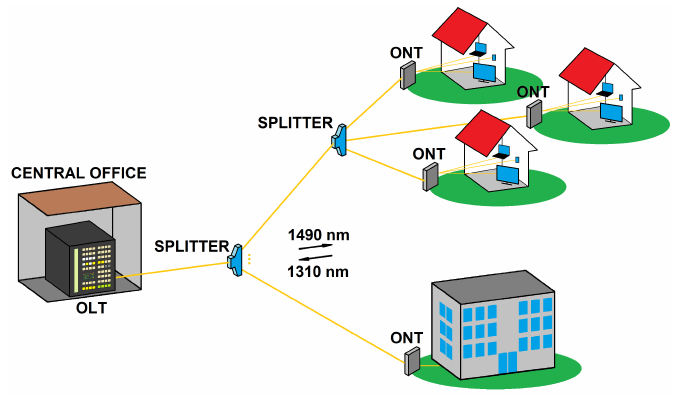
Figure 1. Scheme of a GPON network with an indication of how the distribution of contents from the OLT to the different ONTs using the carriers at 1310 nm and 1490 nm is carried